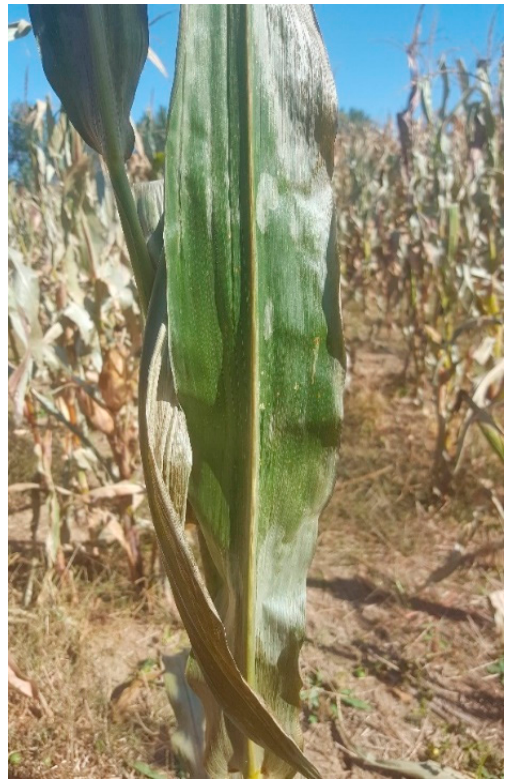
Figure 2. Chilling injury to maize plant after cold stress (XY335 sown in Hebei, China, in 2018). Leaf of maize plant affected by night cold wind of 2–4 °C, showing leaf wilting to leaf blade at the of maize plant affected by night cold wind of 2–4 ◦ C, showing leaf wilting to leaf blade at the late late reproductive stage. reproductive